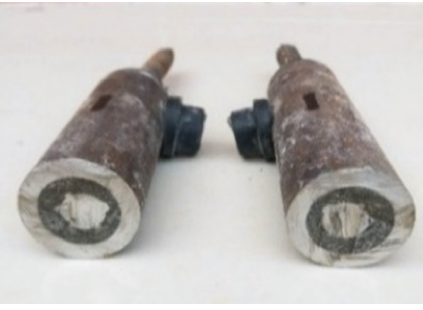
Figure 9: Sliced sleeve